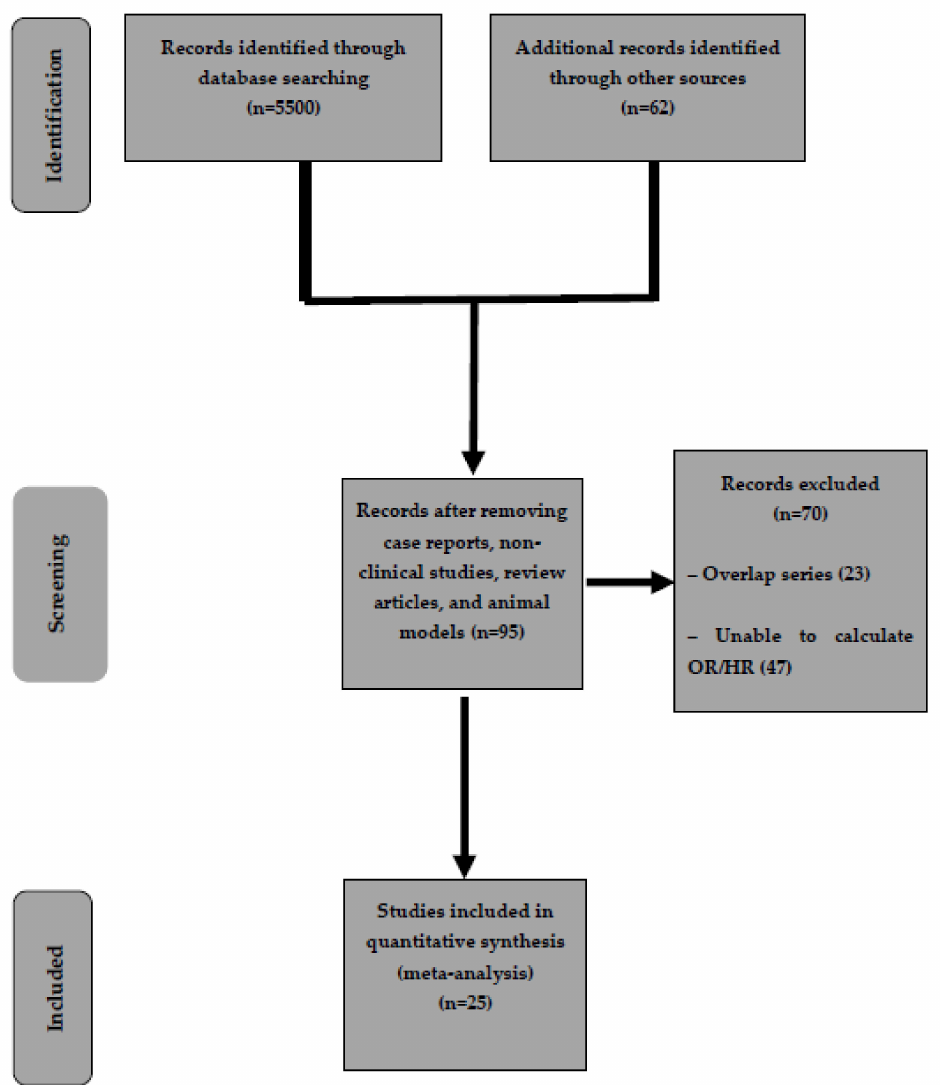
Figure 1. Flow chart of the search strategy conducted in this